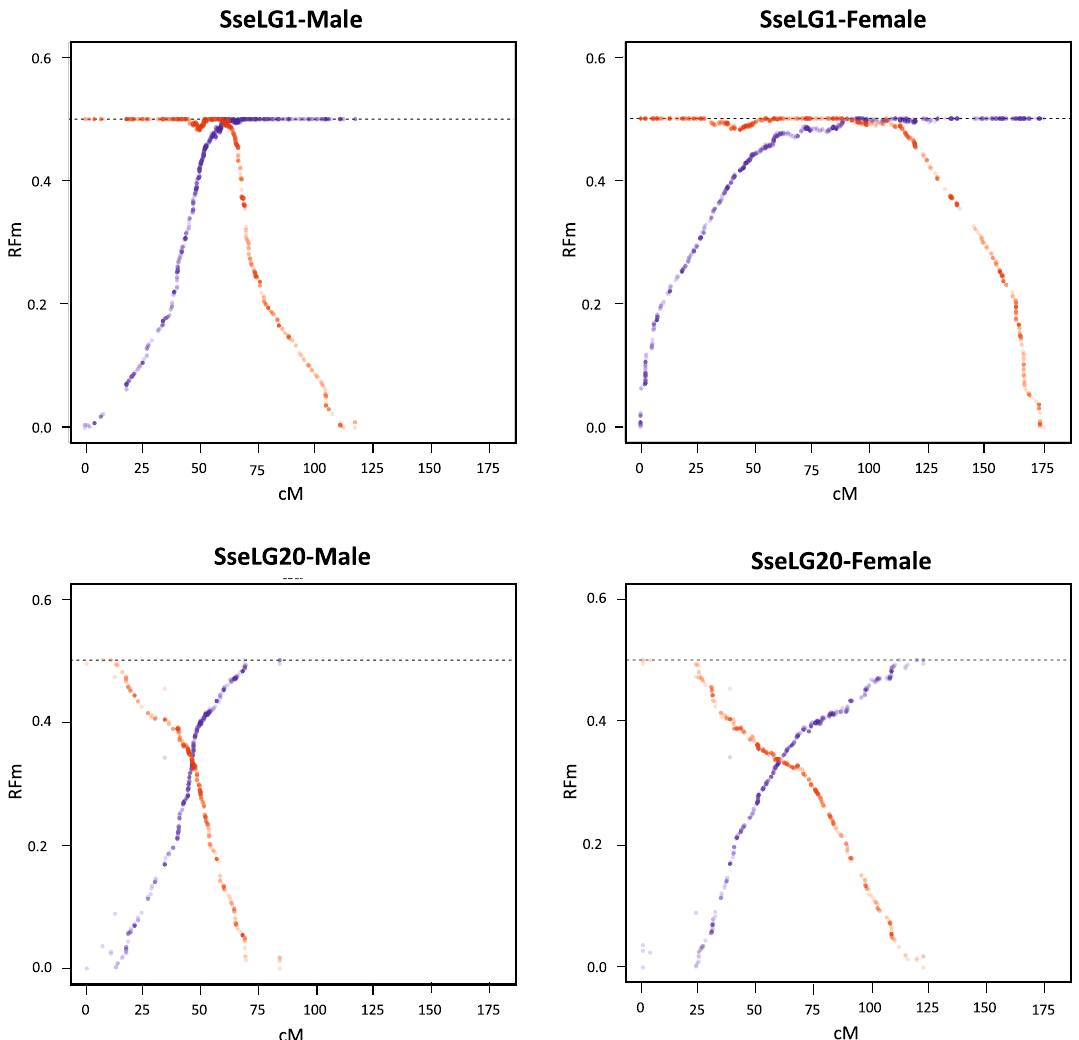
extremities (right: red circles; left: blue circles), using each of the two terminal markers as a reference starting point. The RFm plots of SseLG1 and SseLG20 show a classical metacentric and acrocentric pattern, respectively. The RFm plots of all SseLGs are illustrated in Supplementary Fig.